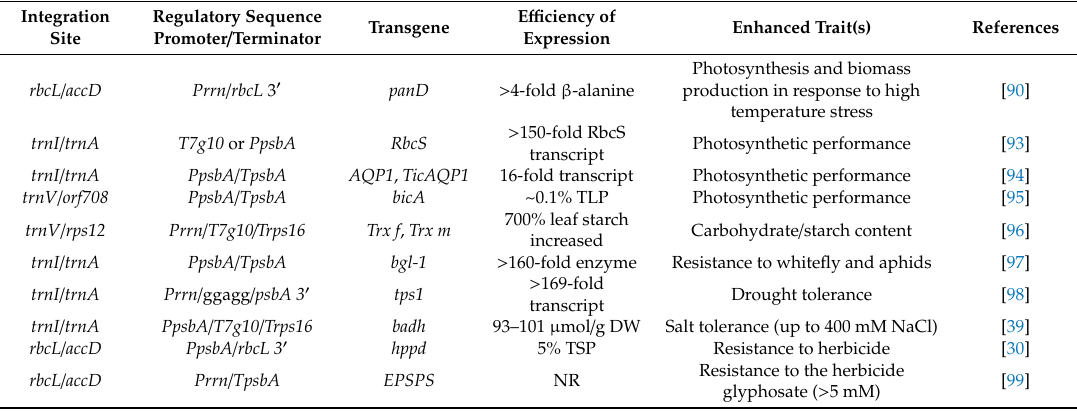
Table 3. Agronomic traits engineered into crops by plastid